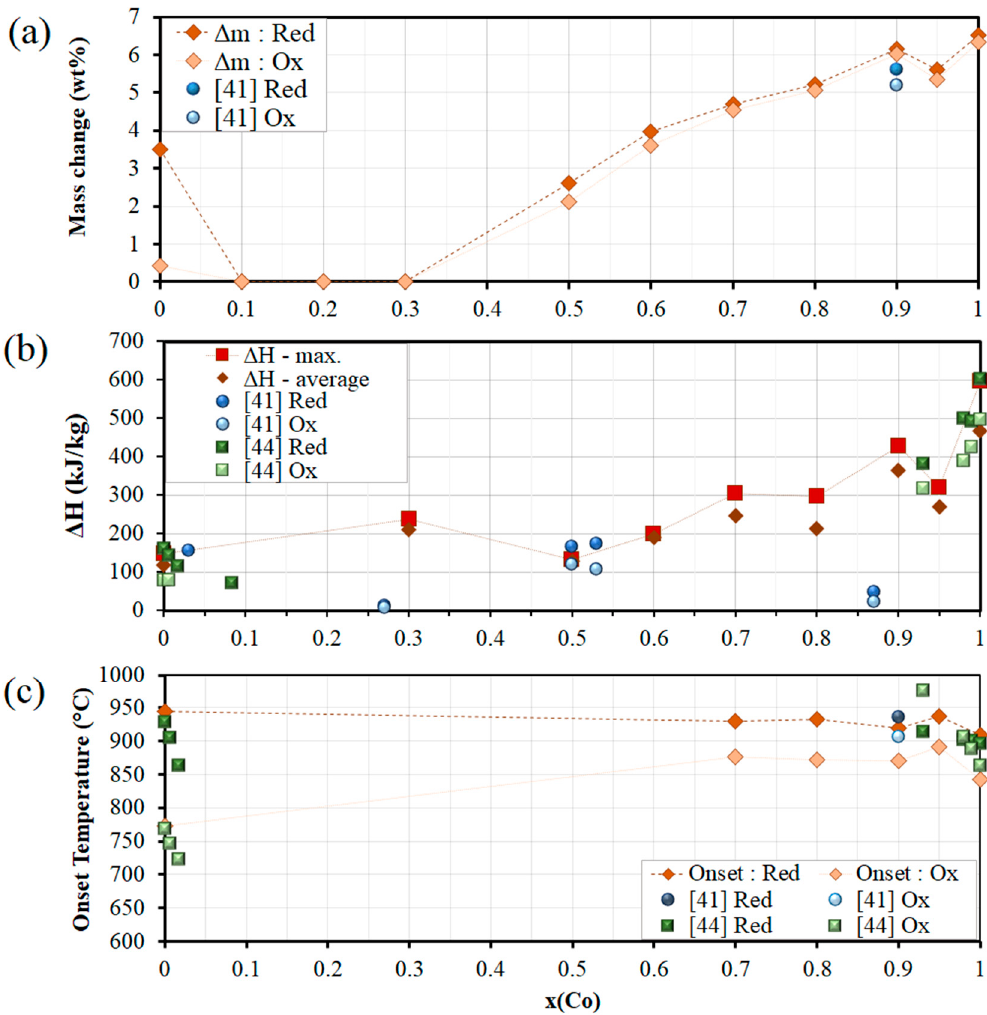
Figure 6. Mass variation (OSC), enthalpy change and onset temperatures of redox reactions measured for the Mn-Co-O system.